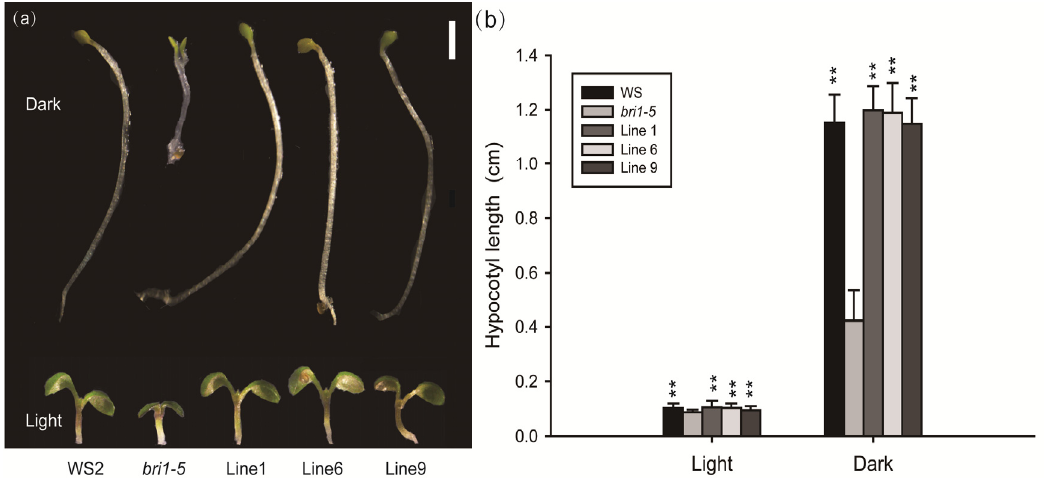
Figure 5. GmBRI1 restores hypocotyl elongation of bri1-5 . ( a ) Morphologies of the six-day-old seedlings grown in light and darkness. Representative seedlings are the wild-type (WS2), bri1-5 mutant and three transgenic lines (Line 1, 6 and 9) from left to right. Seedlings were photographed under a Nikon SMZ1500 dissection microscope using a Nikon DS-Fi1 camera and NIS-Elements F Imaging software. Bar = 1 mm; and ( b ) Average hypocotyl length of seedlings grown for six days in light and darkness. The data represents the mean ± SD of three independent experiments. The asterisks indicate significant differences compared to the bri1-5 mutant ( ** , p < 0.01 by the t